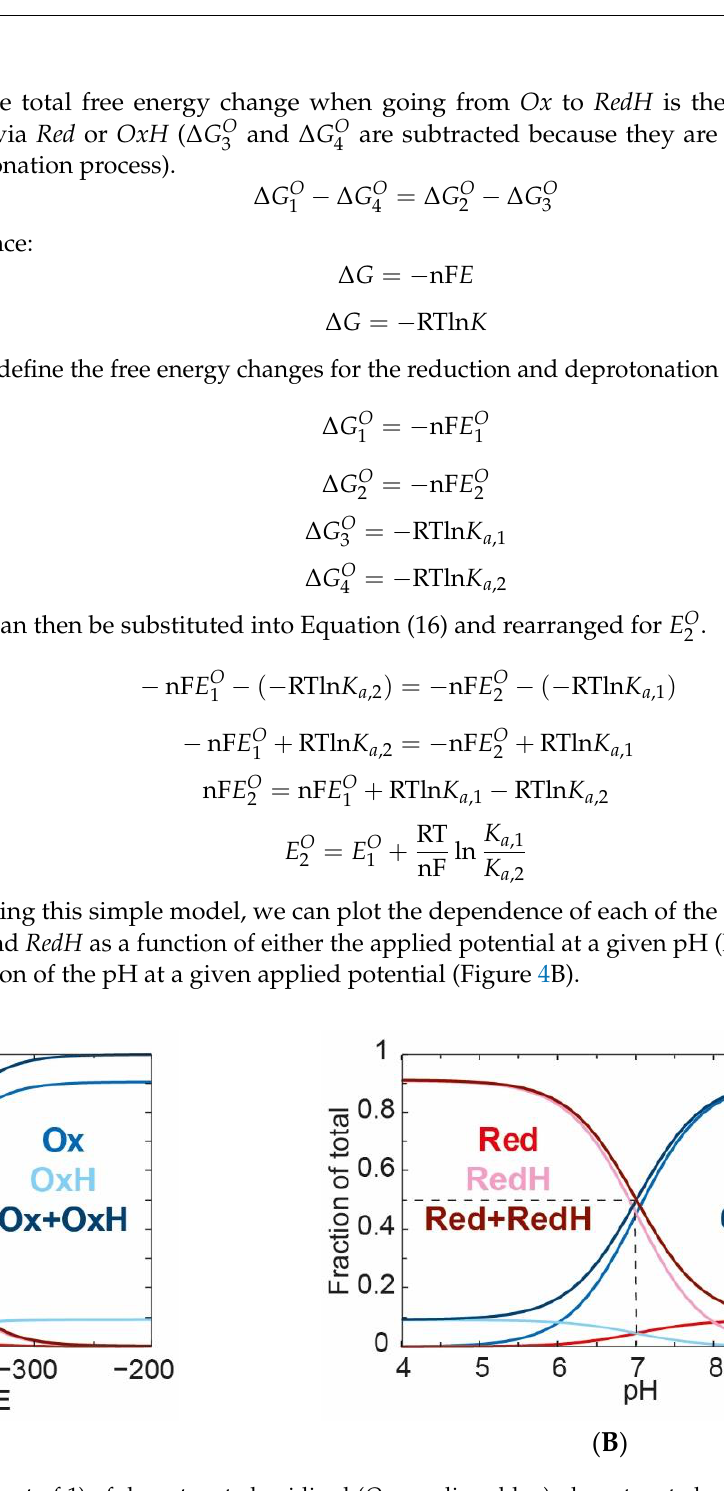
Figure 4. Variation of the fraction (out of 1) of deprotonated oxidised ( Ox , medium blue), deprotonated reduced ( Red , medium red), protonated oxidised ( OxH , light blue), and protonated reduced ( RedH , light red) species as a function of the applied potential ( A ) and pH ( B ). The sum of Ox and OxH (dark blue) and the sum of Red and RedH (dark red) are also plotted. The curves were obtained using Equations (7), (11), (12), and (15), with 𝐸 1𝑂 = −459 mV vs. SHE, K a, 1 = 10 −6 ( pK a, 1 = 6), K a, 2 = 10 −8 ( pK a, 2 = 8), and a pH of 7 ( A ) or an applied potential of −400 mV vs. SHE ( B ). These values are arbitrary, but were chosen here to give conditions where significant PCET can be observed with an apparent redox midpoint potential of −400 mV and an apparent pK a value of 7. 𝐸 2𝑂 was calculated using Equation (21) to be −341 mV, giving an average E O of −400 mV vs. SHE, for a comparison with Figure 2.